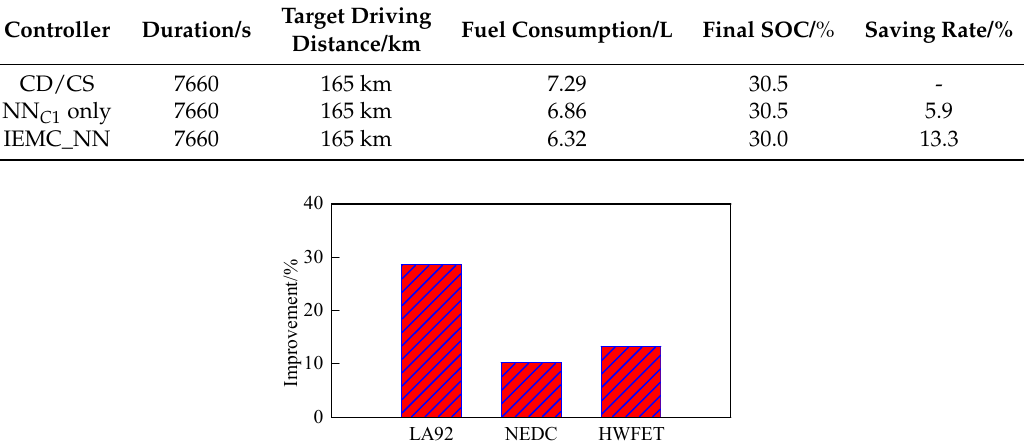
Figure 17. Fuel economy improvements for the IEMC_NN controller compared to the CD/CS